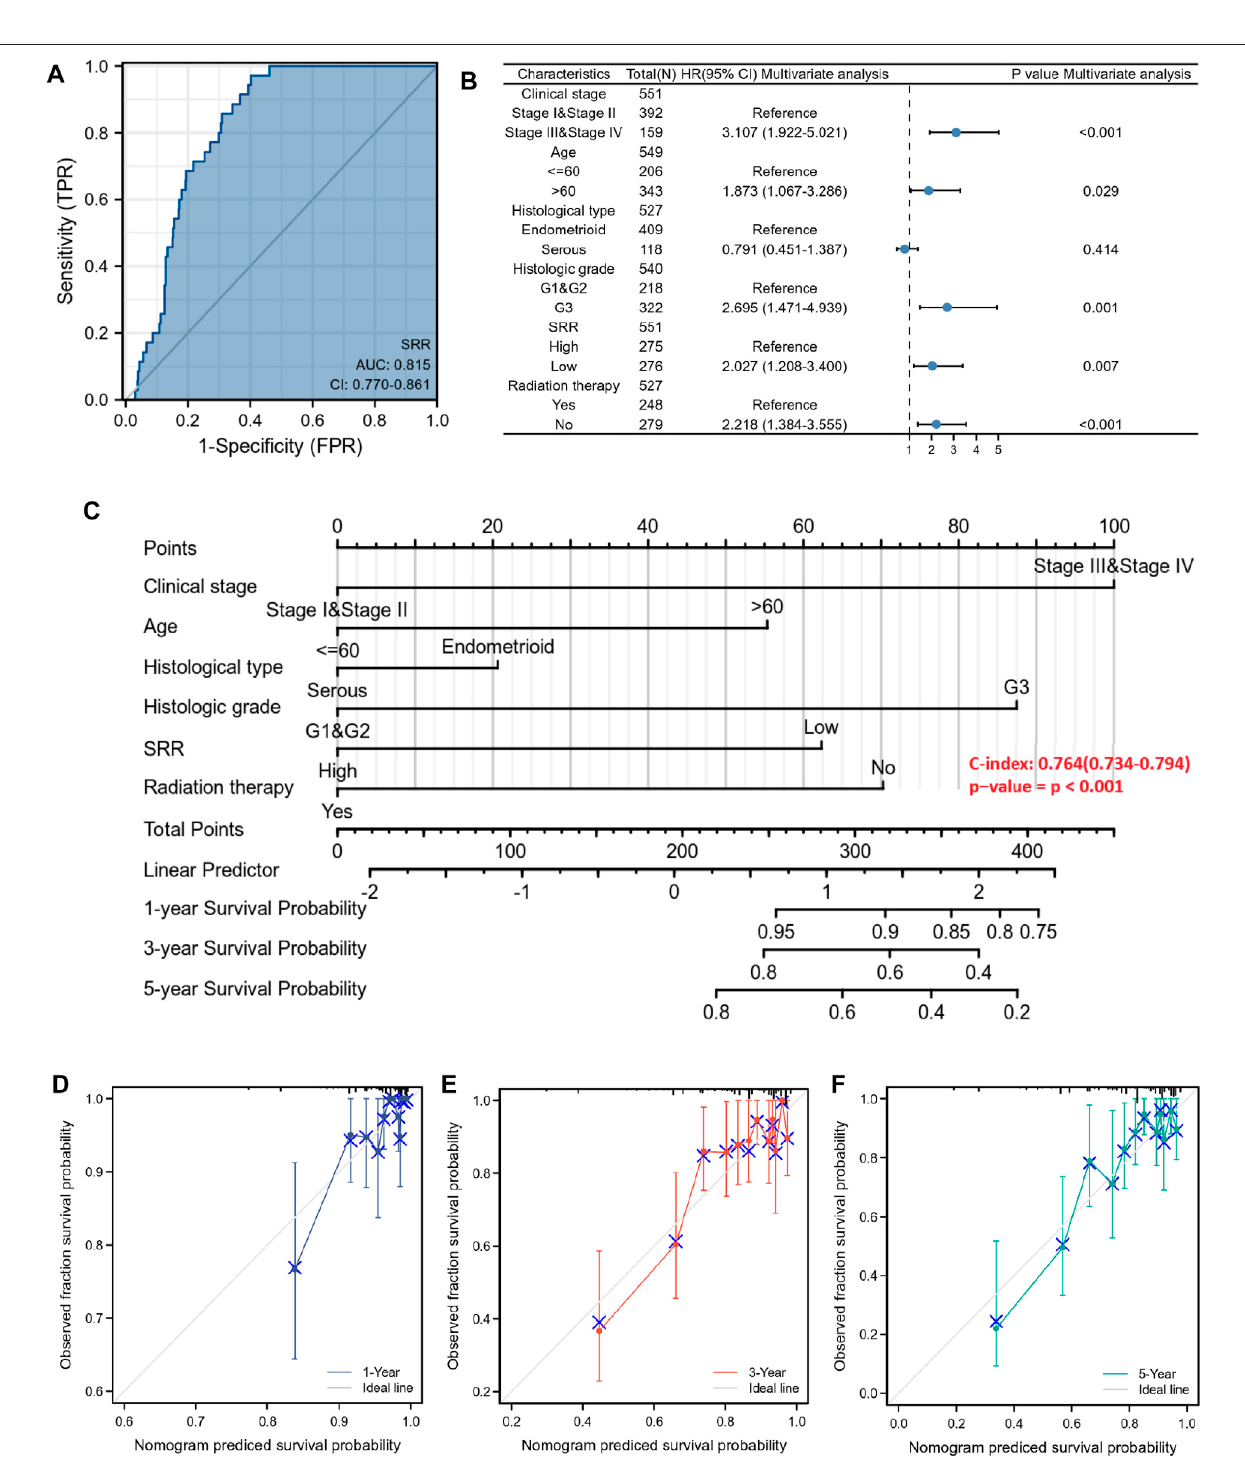
FIGURE 9 | Diagnostic and prognostic value of SRR in UCEC patients. (A) ROC analysis of SRR shows good discrimination power between tumor and normal tissues. (B) Forest plot shows the results of the multivariate Cox regression analysis of the clinicopathological characteristics affecting the OS of UCEC patients. (C) A nomogram for predicting the 1-, 3-, and 5-year OS probability for UCEC patients. (D – F) Calibration curves of 1-, 3-, and 5-year OS of UCEC patients. The ordinate represents the actual OS, while the abscissa represents the nomogram-predicted OS.